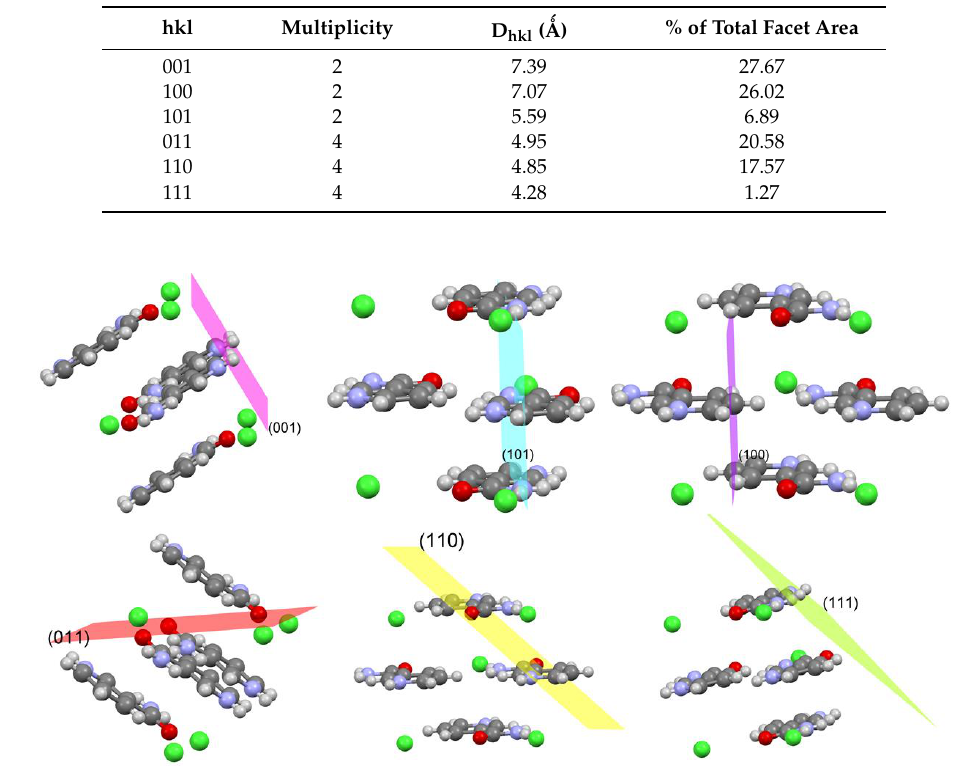
Figure 5. Molecular arrangement of morphologically crystal faces (C 6 H 7 N 2 O) + · Cl − . The relative Miller indices are shown together with the respective outcropping atoms.